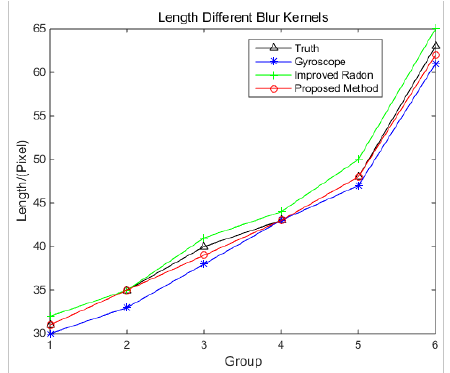
Figure 11. Mean square error (MSE) of the blur kernel by different method.